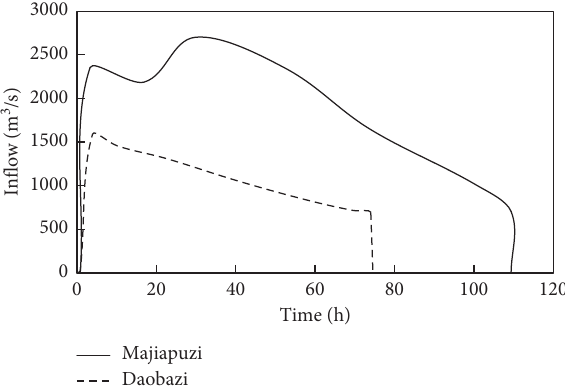
Figure 6: Discharge hydrographs at the dike break